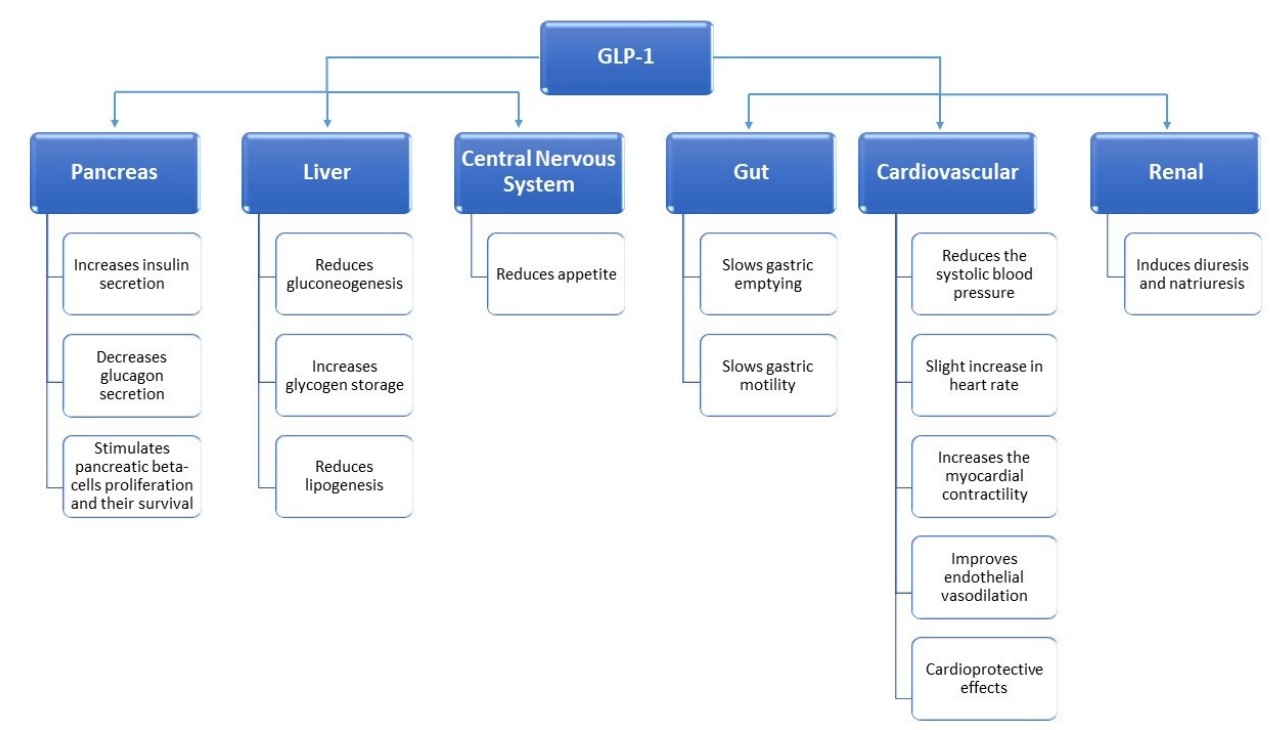
Figure 1. The main biological effects of Glucagon-like peptide 1(GLP-1).